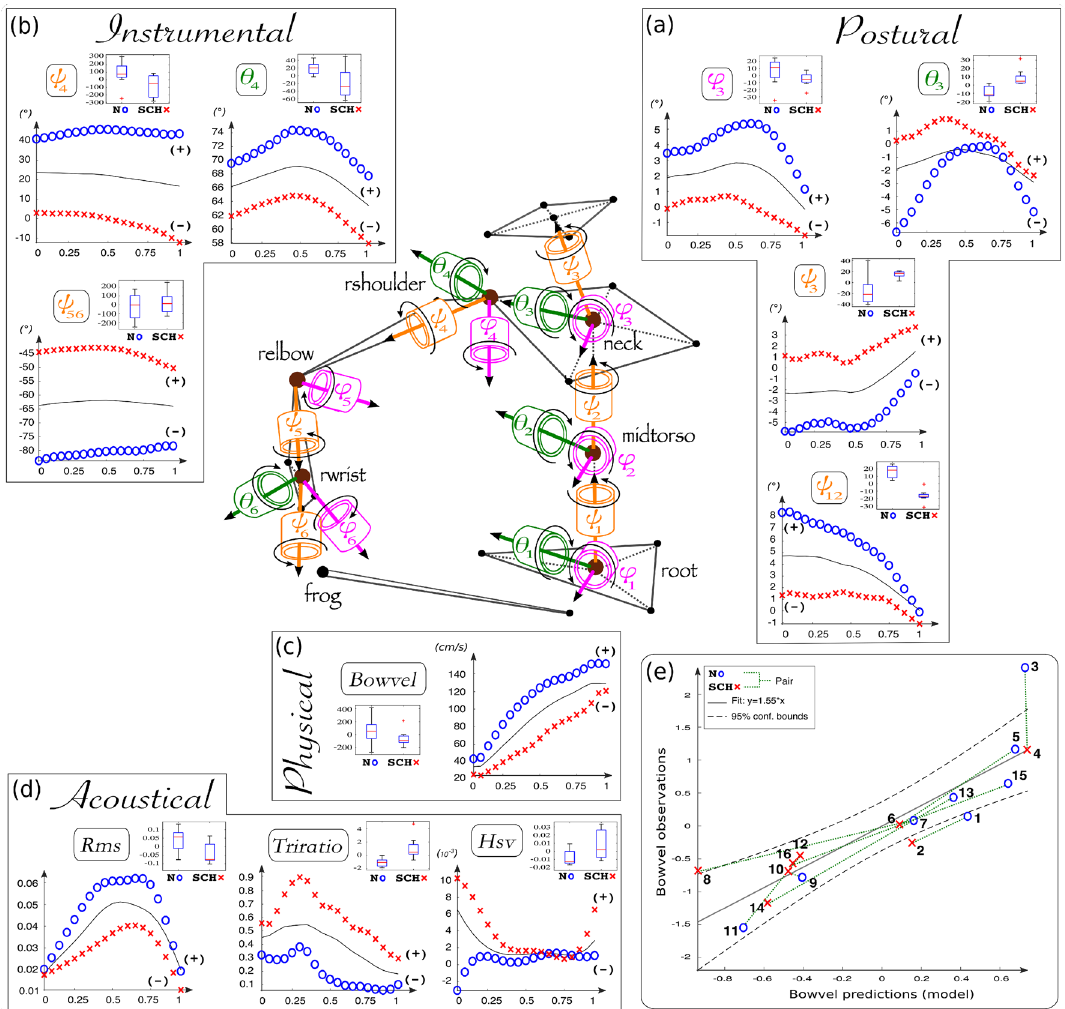
Figure 3. Major mode of the cellists’ functional variations. This mode explained 70% of the variance contained in the kinematic data—( a ) postural, ( b ) instrumental, ( c ) physical—and 60% of the variance contained in the ( d ) acoustical data. At each stage of this functional unit, the effect of the major mode is visualized as functional deviations of the average time series between the normal situation (curves of blue circles) and the constrained situation (curves of red crosses). The attached boxplots present the distribution of FPC1 scores, i.e. the way each individual curve contributed to the major mode, for each variable that significantly discriminated the postural conditions. Normal and constrained functional components were added or subtracted to or from the mean curve, according to the mean sign of the FPC1 scores in each postural condition. The bottom right panel ( e ) shows the graph obtained by linear regression of the major scores (FPC1) of the bow velocity with respect to those of anatomic angles, which were significantly different between the postural conditions ( R = 0.77 ∗∗ R 2 adjusted